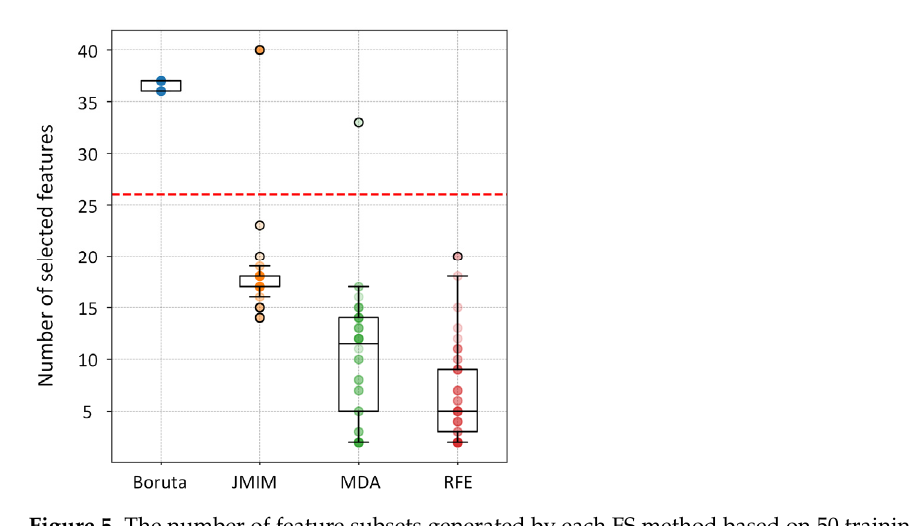
Figure 5. The number of feature subsets generated by each FS method based on 50 training datasets; the red dashed line shows the SHCE results.